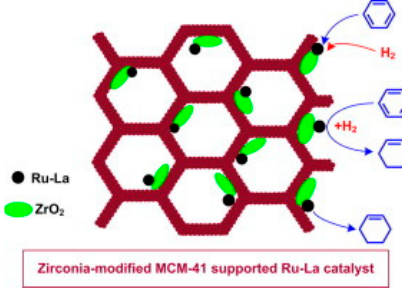
Figure 54. Zirconia-modified MCM-41 supported Ru-La catalyst. Reproduced with permission from [93] Copyright 2014 Elsevier